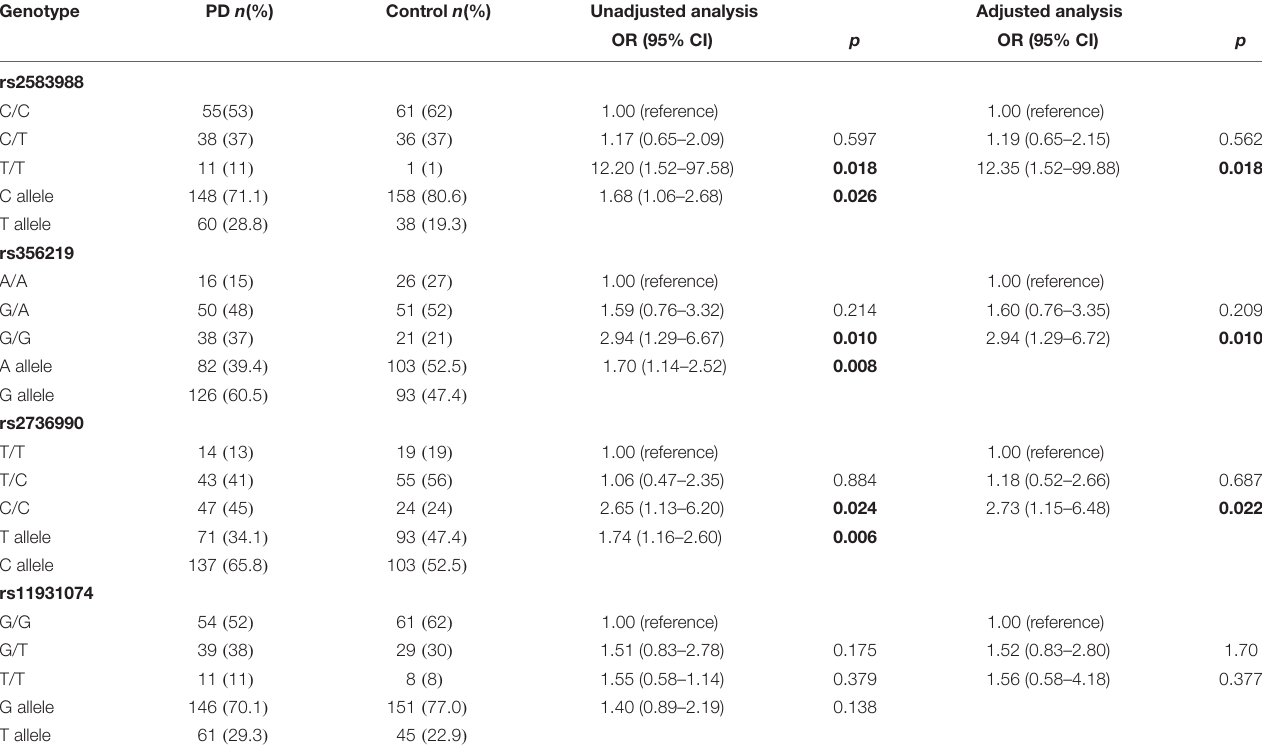
TABLE 3 | Genotypic and allelic frequencies of single nucleotide polymorphisms (SNPs) in alpha-synuclein gene (SNCA) gene in PD cases ( n = 104) and controls ( n = 98). Genotype